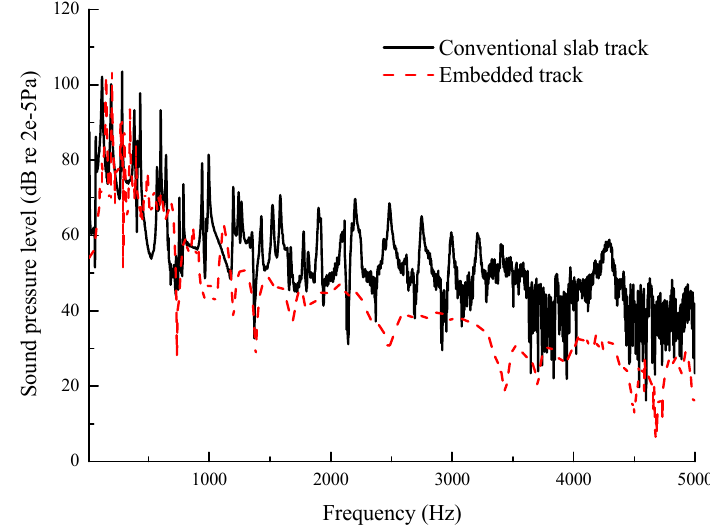
Figure 15. SPLs of track comparison between conventional slab track and embedded track (simulation results).